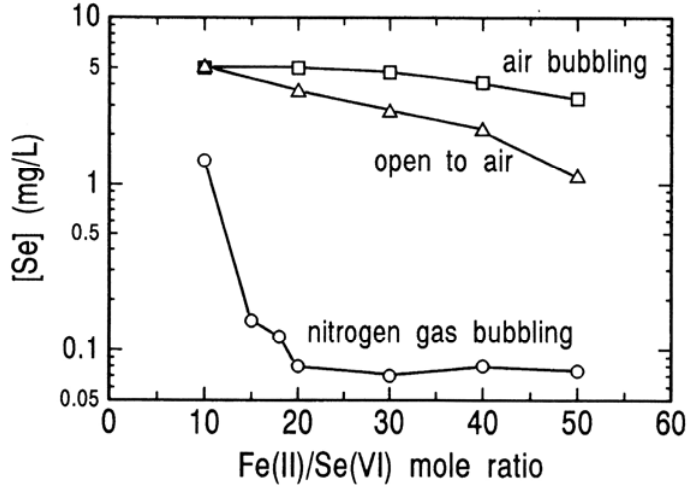
Figure 14. Removal of selenium(VI) by reduction with ferrous hydroxide under different = 5 mg/L; pH = 9.0; 70 °C; 15 atmospheres. [Se(VI)] o